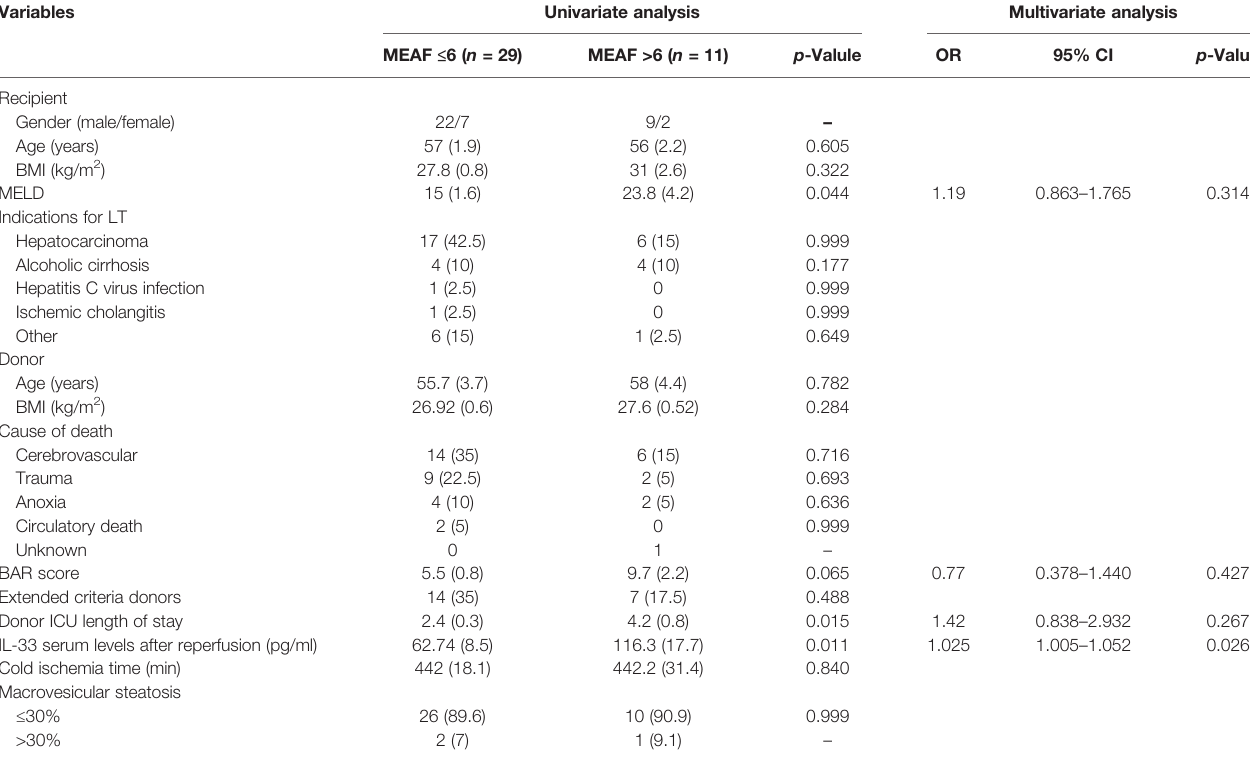
TABLE 1 | Analysis of factors associated with a MEAF score >6 (LT